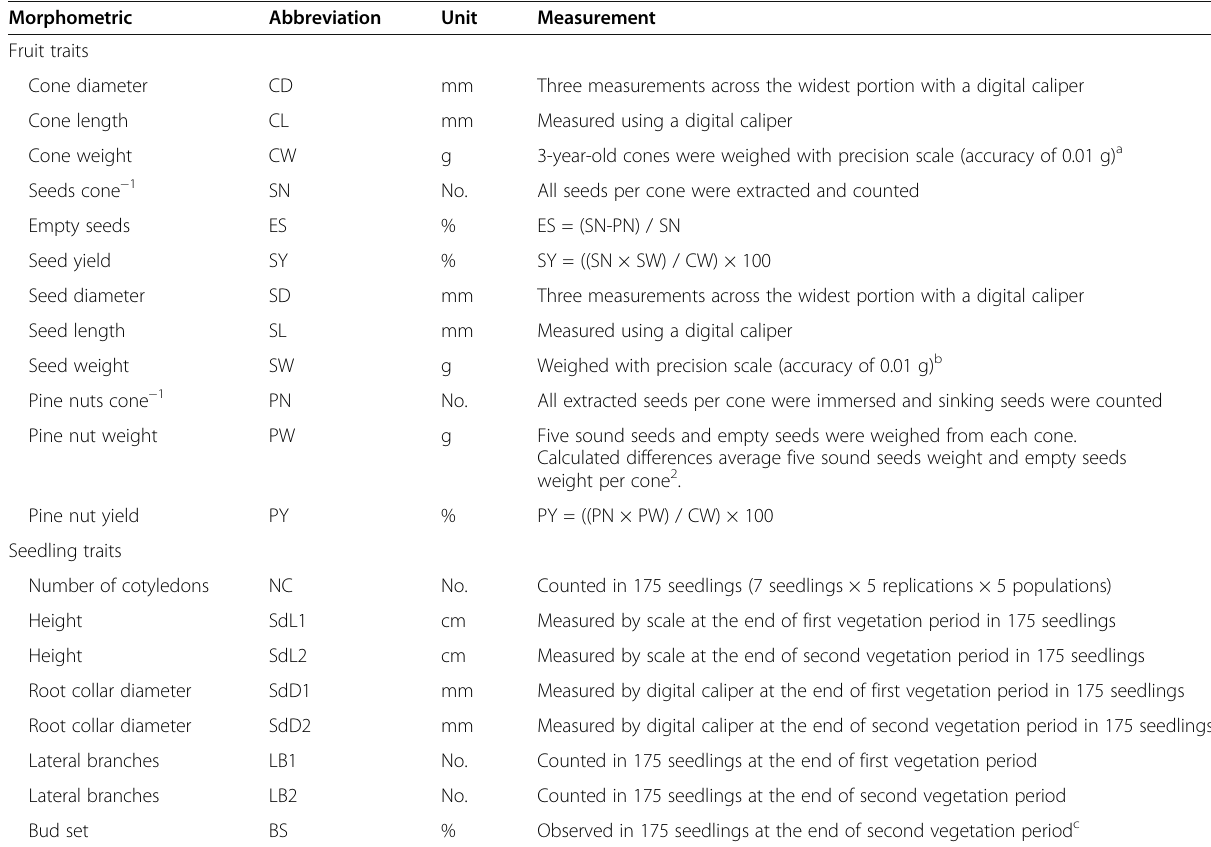
Table 2 List of morphometric traits of P . pinea fruits and seedlings with measurement and units